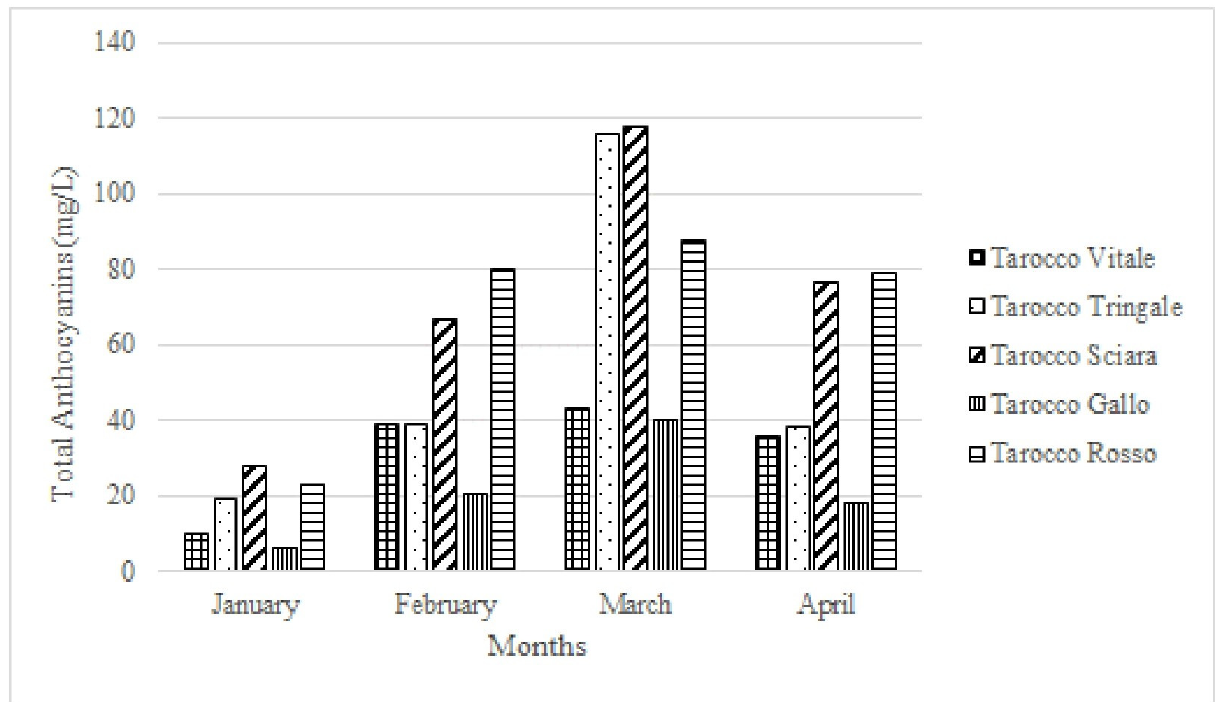
Figure 5. Change in anthocyanin content in different ‘Tarocco’ selections during maturation.